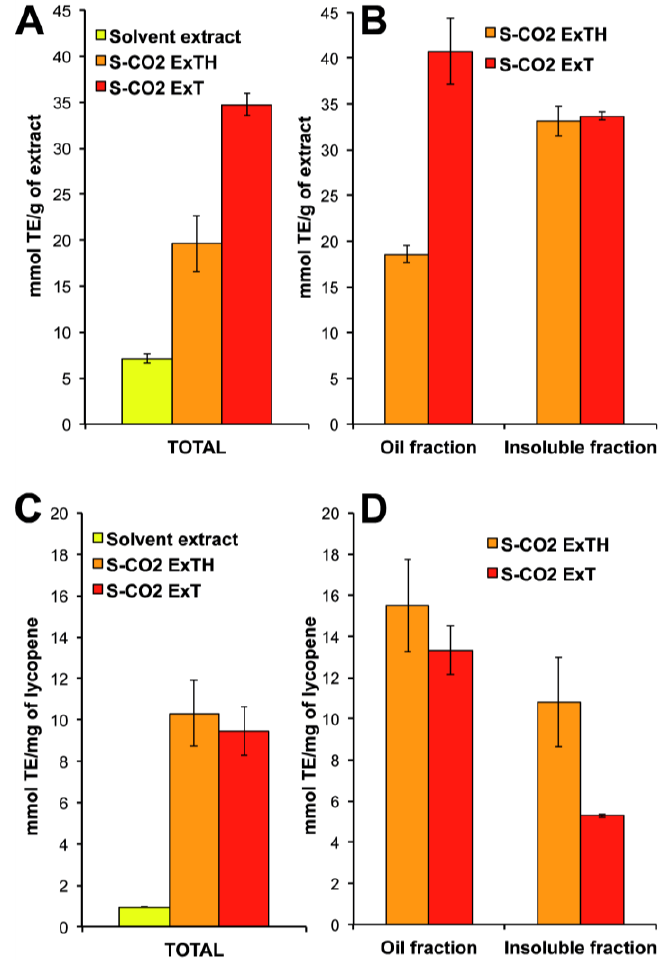
Figure 4. Antioxidant activity in the total extracts, oil- and insoluble-fractions of the S-CO 2 extracted oleoresins. Antioxidant activity was expressed as mmol of trolox equivalent (TE) per gram of sample ( A , B ) or per mg of contained lycopene ( C , D ). S-CO ExT: oleoresin 2 extracted by S-CO from pure tomato powder; S-CO ExTH: oleoresin extracted by S-CO 2 2 2 from tomato/hazelnut powder; Solvent extract: tomato powder extracted by hexane. Data are mean ± SD of three measures from three independent